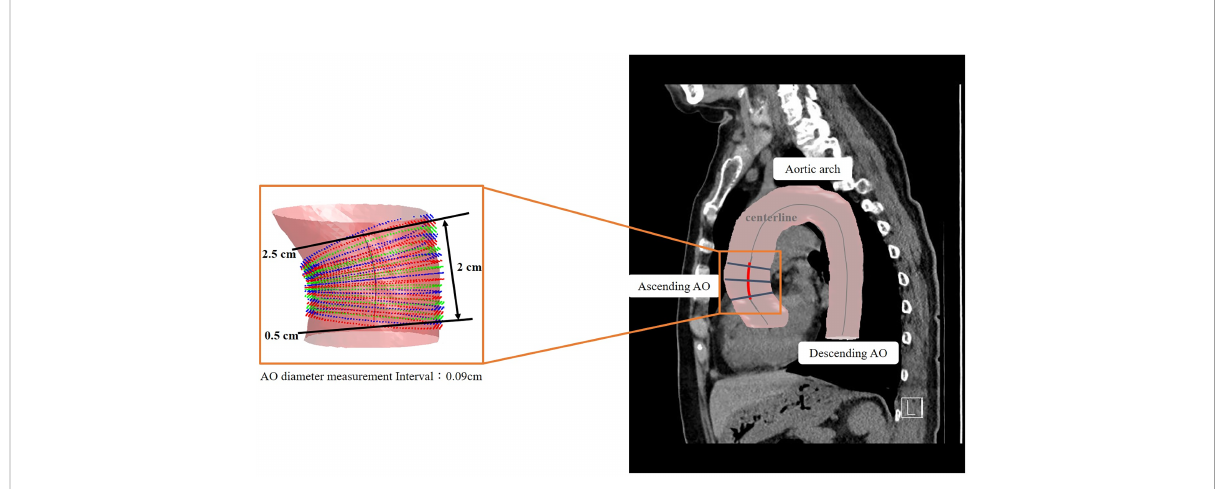
FIGURE 3 Illustration of 3D automated measurement of aorta (Ao) diameter. The centerline was marked on the 3D segmented image. The Ao diameter was measured from 0.5 cm after exiting the heart to a position of 2.5 cm. The Ao diameter was de fi ned as the mean value of calculated diameters at every 0.04-cm interval.